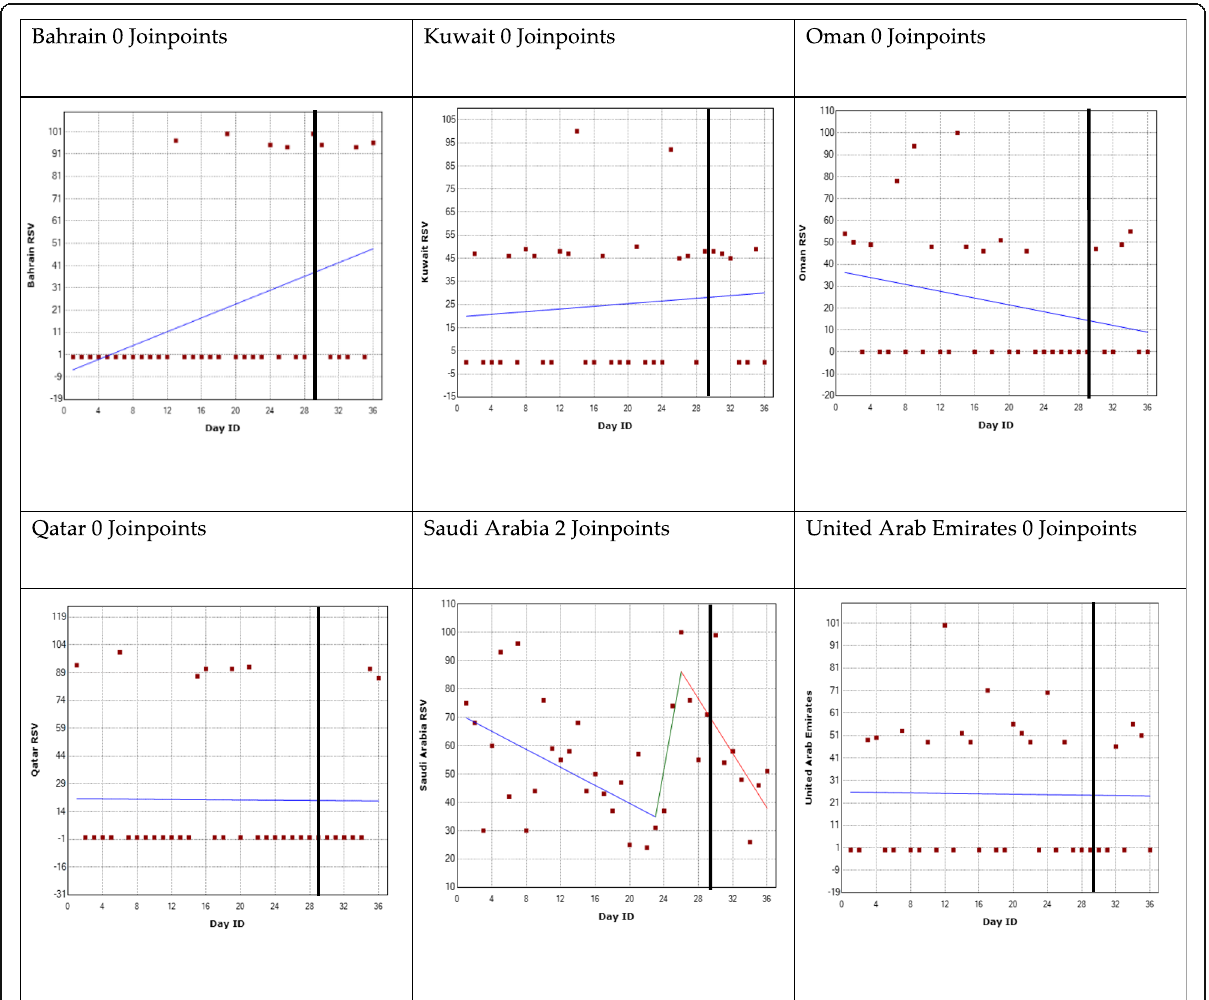
Fig. 4 World Heart Day joinpoint regression analysis. *The black vertical line represents the global public health